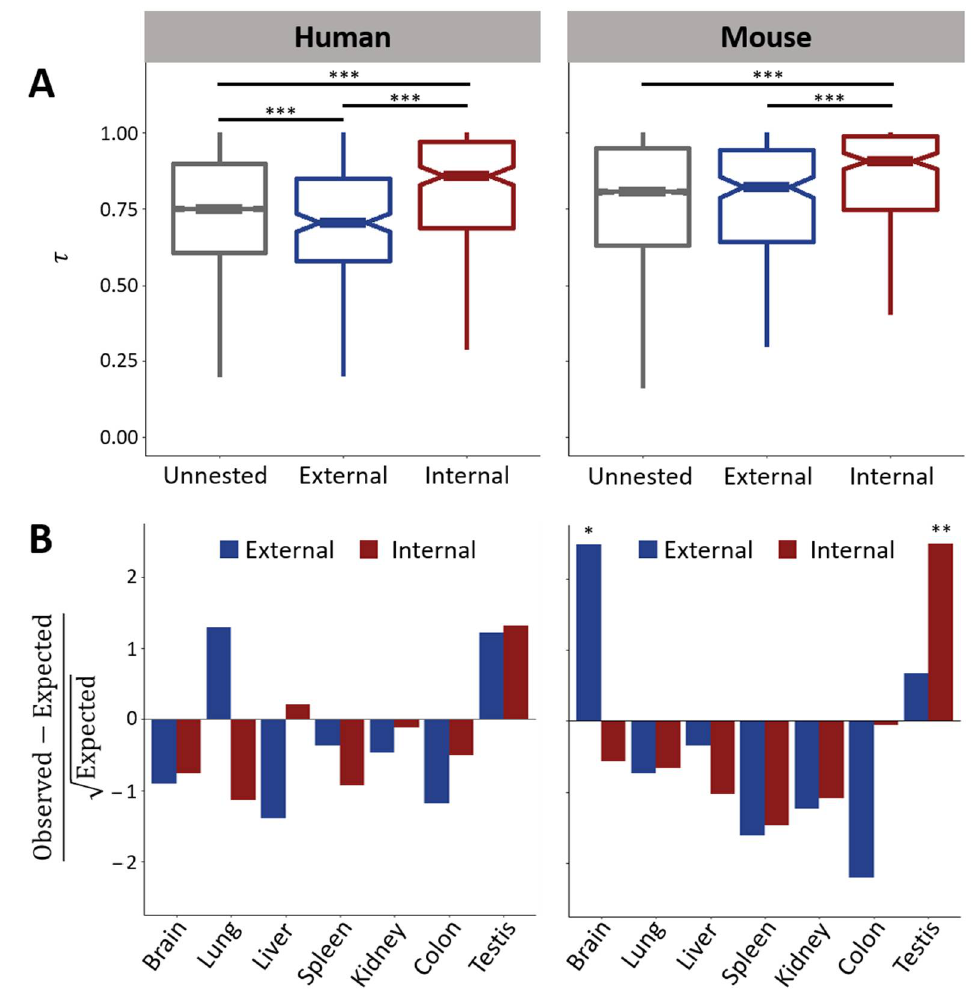
Figure 1. Expression breadths of external and internal protein-coding genes. ( A ) Distributions of tissue specificities ( τ ) across seven tissues in human (left) and mouse (right) unnested, external, and internal genes. Higher τ corresponds to greater tissue specificity. ( B ) Hanging chi-grams comparing observed numbers of human ( left ) and mouse ( right ) primary tissues of tissue-specific external and internal genes to expectations based on those of unnested genes. Positive and negative values indicate over-representations and under-representations, respectively. * p < 0.05, ** p < 0.01, and *** p < 0.001 (after Bonferroni corrections for Figure 1B; see Materials and Methods for details). Table 2. Numbers of Tissue-Specific External and Internal Protein-Coding Genes.